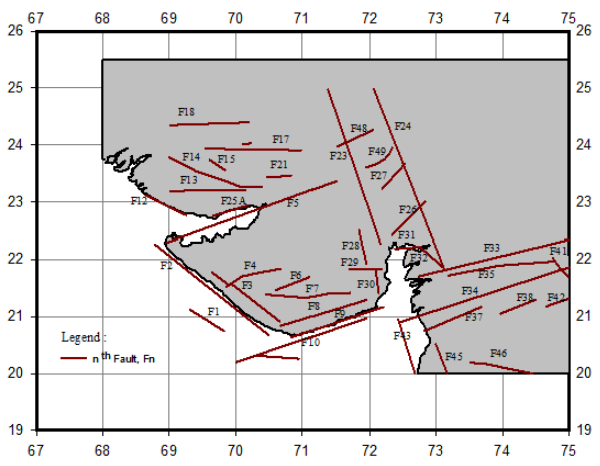
Fig. 5. The Fault map used in the present study.